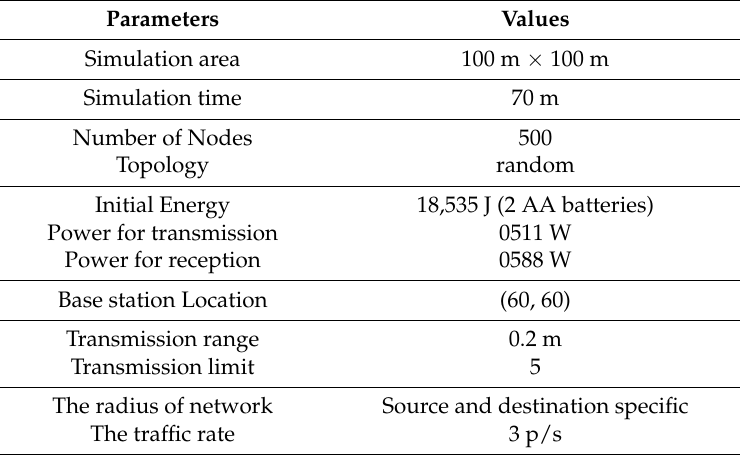
Table 1. Simulation parameters.